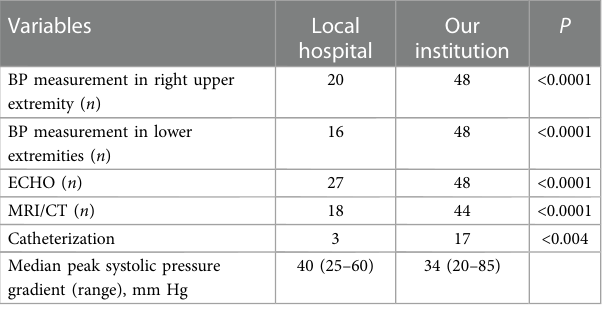
TABLE 2 The number of patients with upper and lower limb BP measurement, ECHO and CT examination.